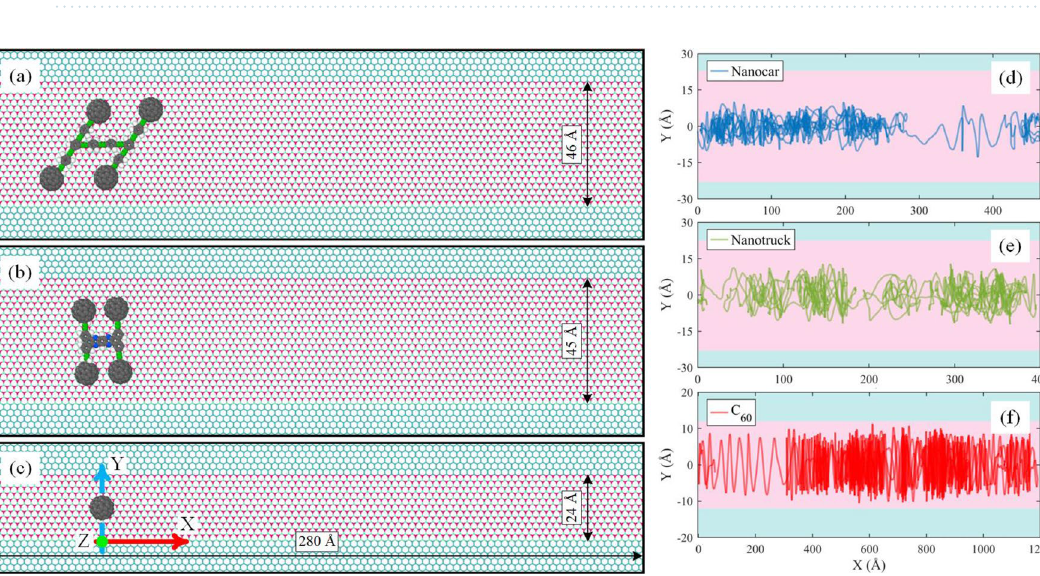
Table 1. The desorption temperatures of C 60 calculated for different sizes of boron-nitride impurity in the middle of the graphene substrate.